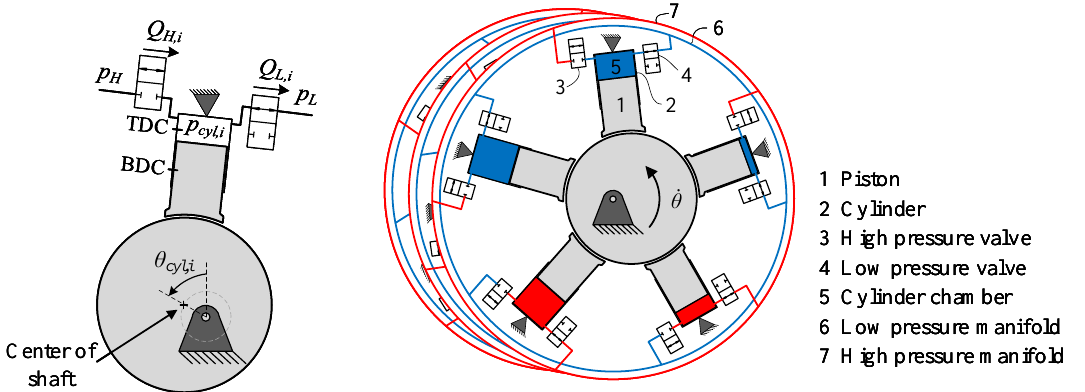
Figure 1. Sketch of a single cylinder chamber ( left ) and a 15-piston DDM ( right